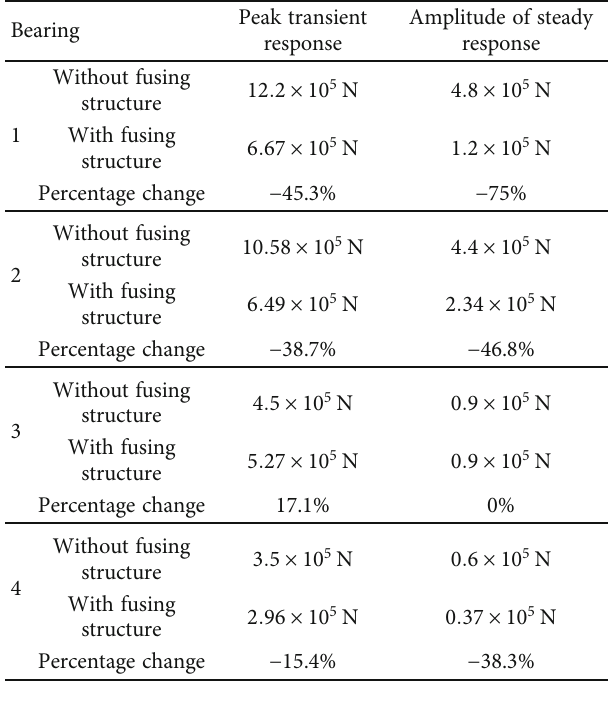
Table 6: Response of low-pressure compressor disk with a variable-sti ff ness fusing structure.